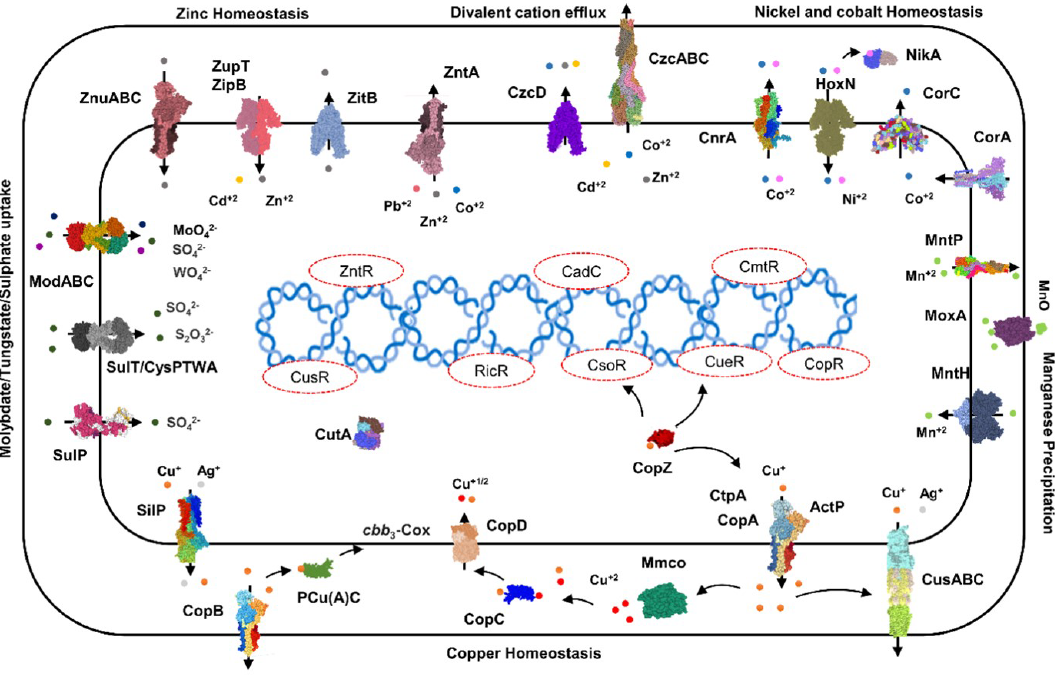
Figure 8. Heavy metals transport channels and enzymes. The metalloregulatory transporters, enzymes, chaperones, and transcription factors form the specific protein–metal coordination complexes involved in the heavy metal transport, intracellular trafficking, storage, and detoxifi- cation are derived from the MAGs pathway maps (supplementary pdf files) and Prokka annotations (Arif et al., 2021a). Copper homeostasis is maintained through the efflux pumps CopA, CtpA, ActP, and CopB under aerobic conditions which remediate the high cellular Cu + contents. The CopZ acts as allosteric switch to detect the excess copper ions, and activate the transcription of the CopABCD operon and multicopper oxidase MmcO through Cu-based inactivation of CsoR and CueR repressors. The periplasmic Cu + is oxidized to the less soluble Cu 2 + by MmcO and CopC that both bind Cu + / 2 + as storage and metallochaperone proteins, while PCu(A)C chaperones facilitate the biogenesis of the copper centre in the cytochrome